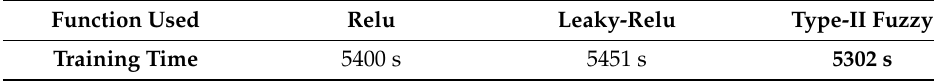
Table 3. Comparison of network training time with different functions.